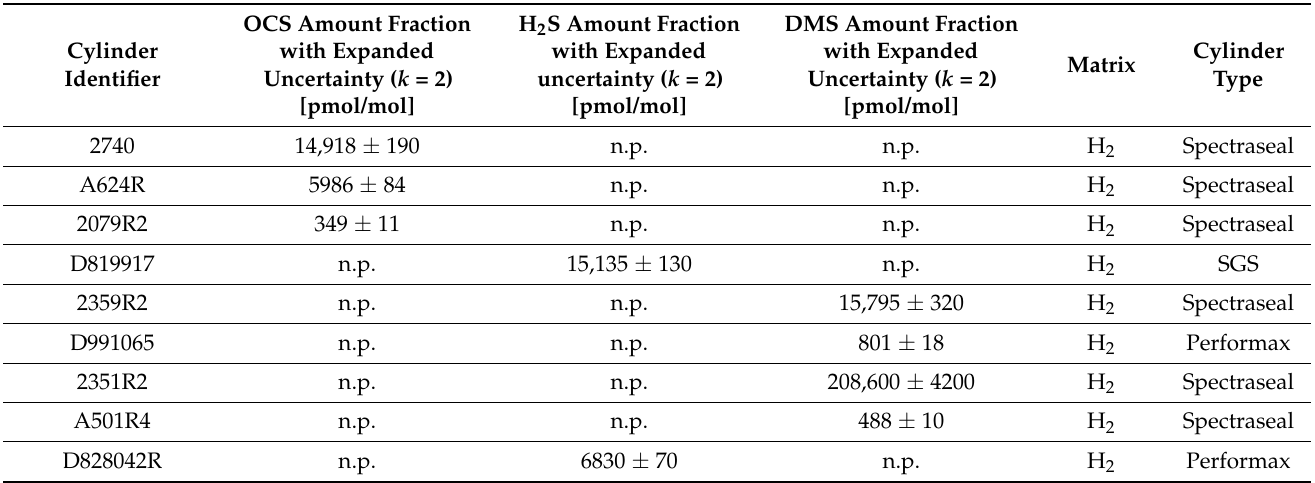
Table 1. List of gas standards prepared for the study and sulphur amount fraction in hydrogen for each gas standard: n.p.: not present—the compounds were absent and considered zero